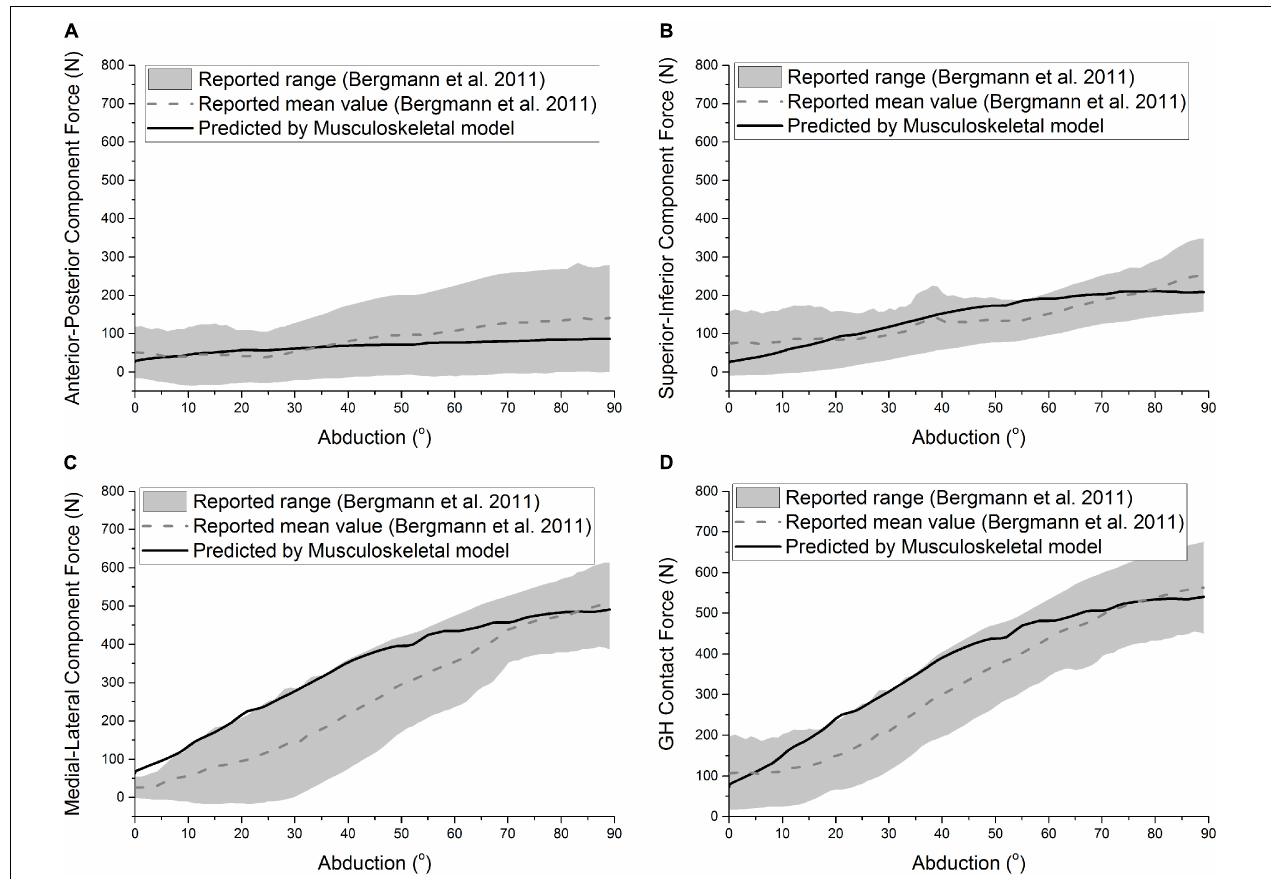
FIGURE 2 | Predicted anterior-posterior component force (A) , superior-inferior component force (B) , medial-lateral component force (C) , and GH contact force (D) of ATSA was compared with the results of Bergmann et al. (2011) during the abduction. The gray area and the dashed line represent the range and mean value formed by the measured GH forces of six